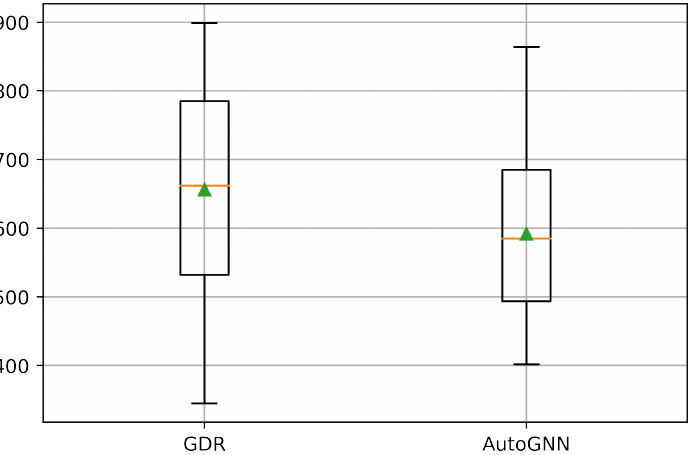
Figure 12. Evaluation on network with 15 nodes.